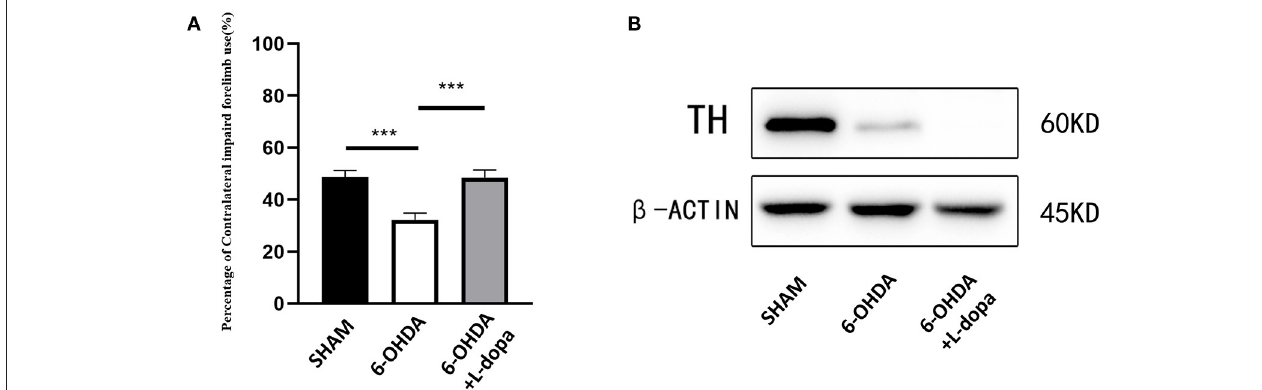
FIGURE 2 | Cylinder test and examination of TH. Motor behavior assessments and the expressions of TH were compared among three groups. (A) The data of the cylinder test. The 6-OHDA injections reduced the percentage of left forelimb use, while after chronic L-dopa administration, the percentage of left forelimb use was improved ( p < 0.001). n = 18–24 for each group. (B) Western blot was used to examine the expressions of TH in the different groups. n = 5 for each group. *** p <